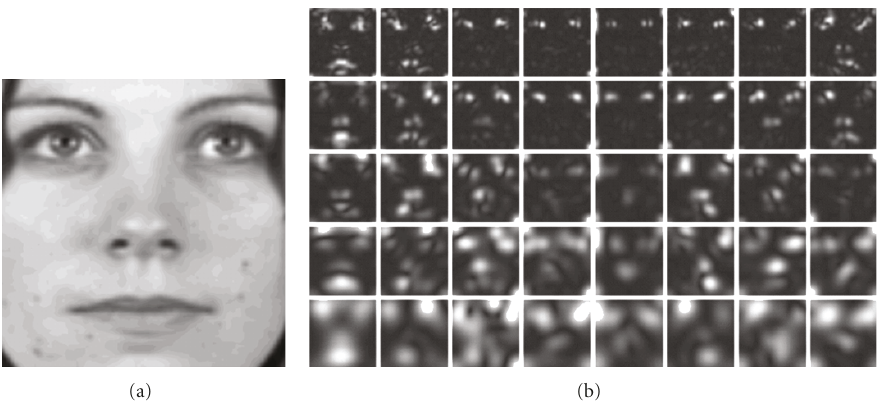
Figure 3: An example of the Gabor magnitude output: a sample image (a) and the magnitude output of the filtering operation with the entire Gabor filter bank of 40 Gabor filters